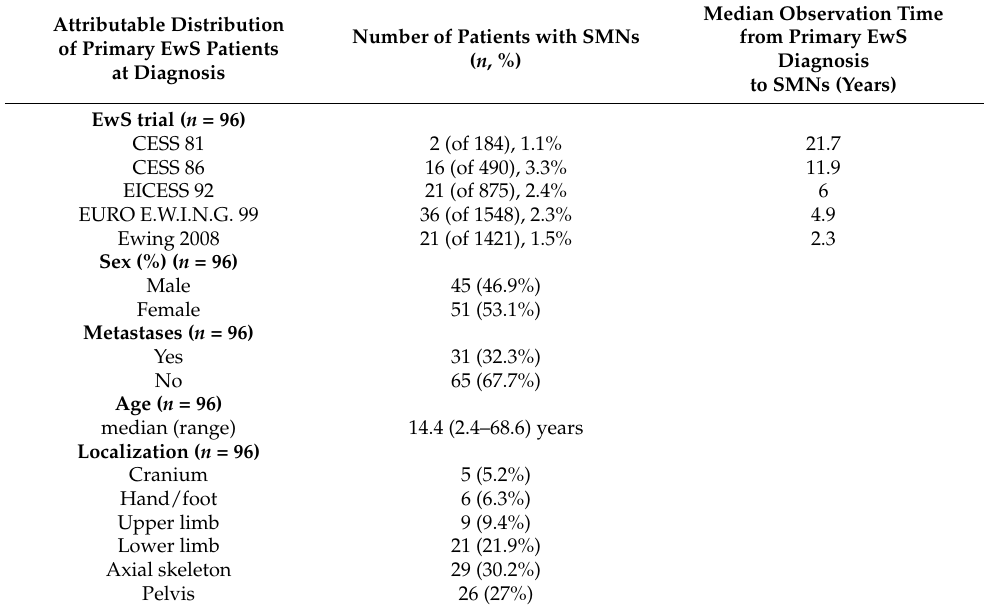
Clinical data of five patients with >1 subsequent malignant neoplasm are summarized in Supplementary Table